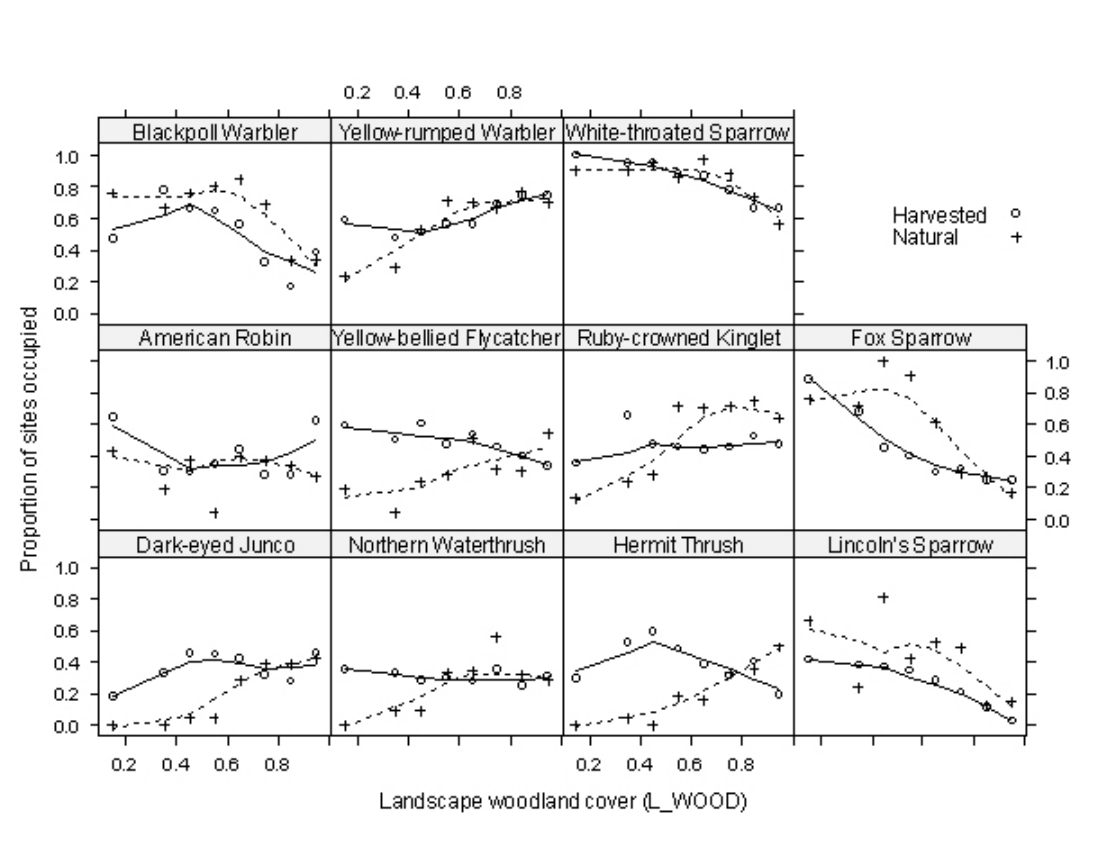
Fig. 2. Species incidence (proportion of sites occupied) by the amount of woodland in the landscape (L_WOOD in statistical models). Curves are smoothed loess regression lines (span = 0.8) to show general trends in the data. Species are ordered by increasing overall incidence from the bottom left panel to the upper right